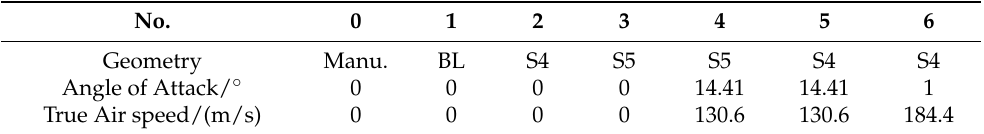
Table 4. Load conditions (steps) analysed in FE model.